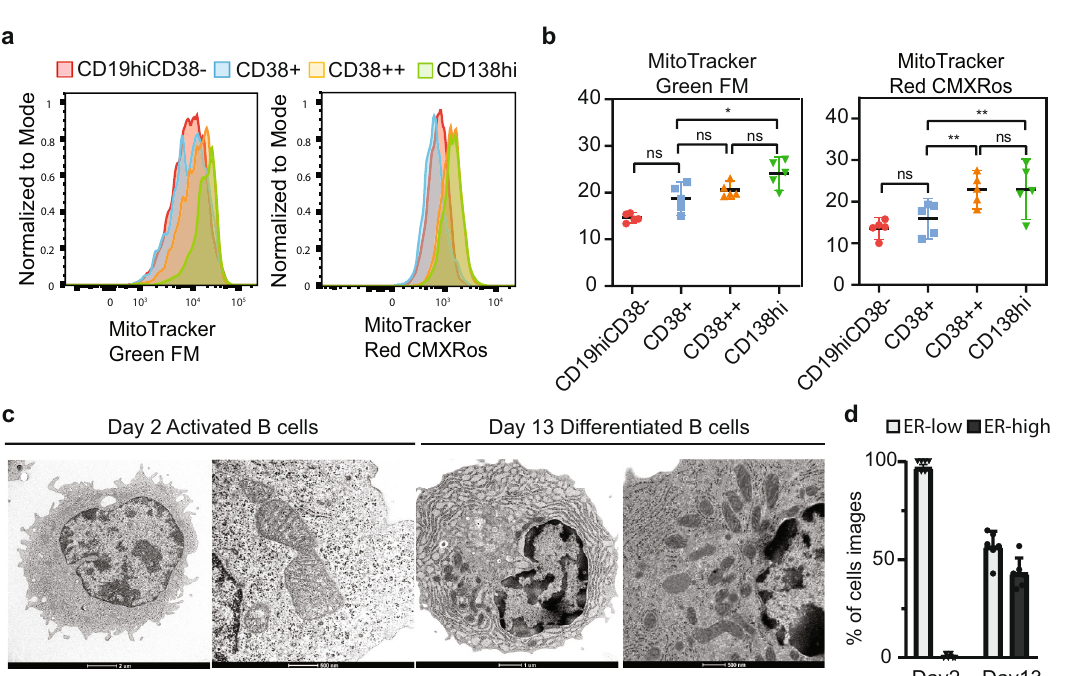
Fig. 1 | Single-cell transcriptomics illustrate the heterogeneity of ex vivo dif- ferentiated human PCs. a Schematic of B cell culture ex vivo, and experimental setup: day 7 and day 13 cells were collected for CITE-seq. It was partially created with BioRender.com. b Single-cell graph by PAGA trajectory analysis of day 7 and day 13 cells, and heatmap by inferred pseudotime of all cells ( n =6011) from both timepointandtwobiologicalreplicates.Trajectorystartsfromtheinitialstatenode (cluster 1, activated B cells from day 7 cells) and ends at terminal state nodes (cluster 0/5, kappa/lambda PCs from day 13 cells). Cell differentiation states in between are labeled according to their representative cell status. c Single-cell tra- jectorygraph heatmapshowing expression of representative geneswhichindicate each cell status. d Expression heatmap of Louvain clusters, gene sets in each pathwayshowgeneregulationalongBcelldevelopment.Eachdatapointpresentin